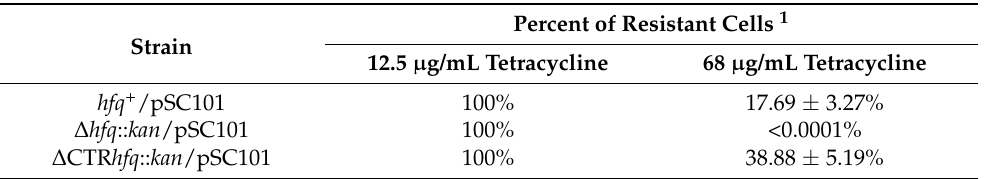
Table 5. Resistance of E. coli hfq +, ∆ hfq :: kan, and ∆ CTR hfq :: kan strains bearing the pSC101 plasmid to different concentrations of tetracycline.